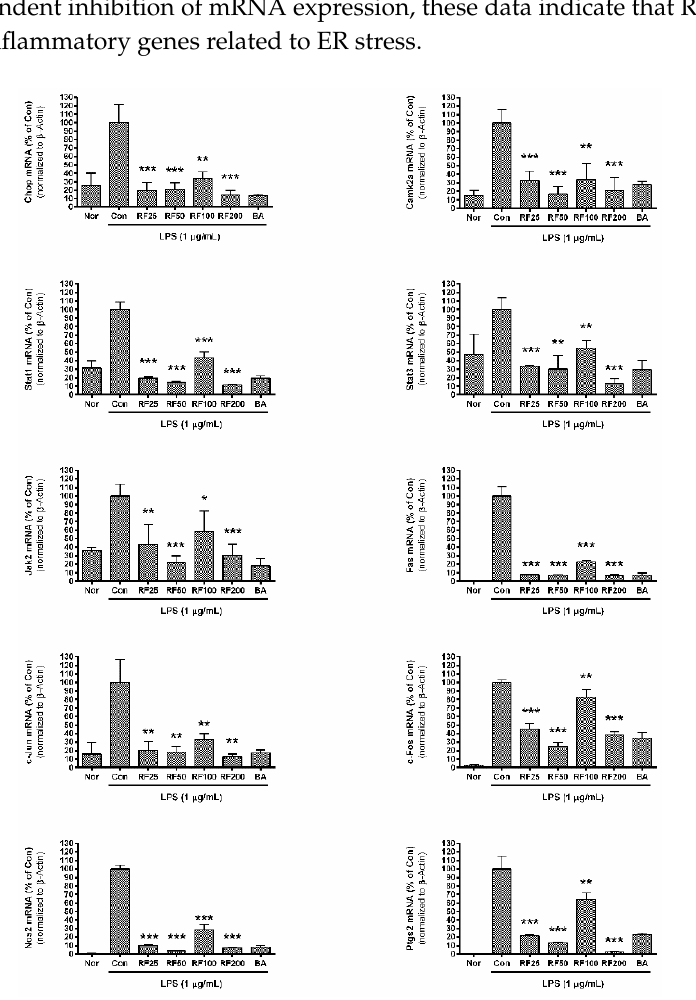
Figure 3. E ff ects of Rubi Fructus water extract (RF) on mRNA expression of Chop, Camk2a, Stat1, Stat3, Jak2, Fas, c-Jun, c-Fos, Nos2, and Ptgs2 . Cells were treated for 18 h. “Nor” indicates the group treated with media only. “Con” indicates the group treated with 1 µ g / mL of LPS alone. RF25, RF50, RF100, and RF200 indicate treatment with 25, 50, 100, and 200 µ g / mL of RF, respectively. “BA” indicates treatment with baicalein (25 µ M). Values represent means ± SD of three independent experiments ( n = 3). Statistical significance was calculated by one-way ANOVA and a Tukey multiple comparison test. * p < 0.05 vs. Con; ** p < 0.01 vs. Con; *** p < 0.001 vs.